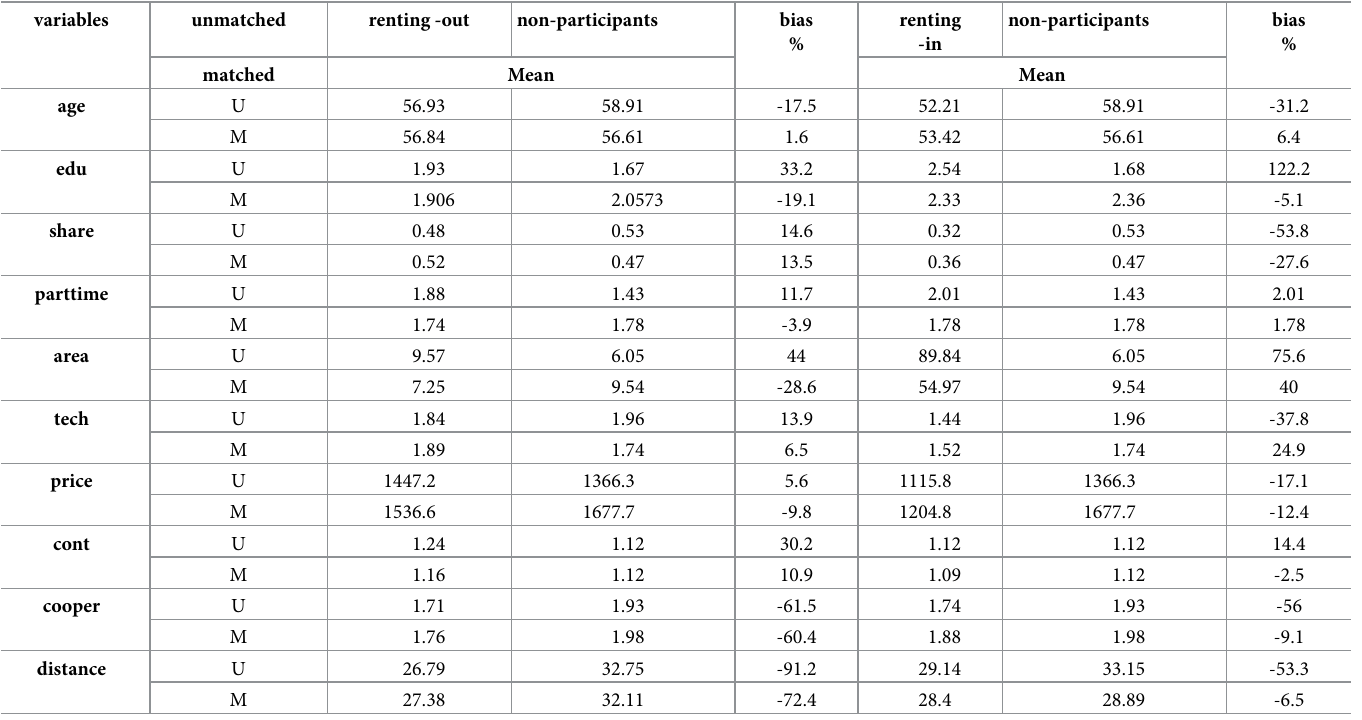
Table 5. Balance test of control variables by nearest neighbor matching method.